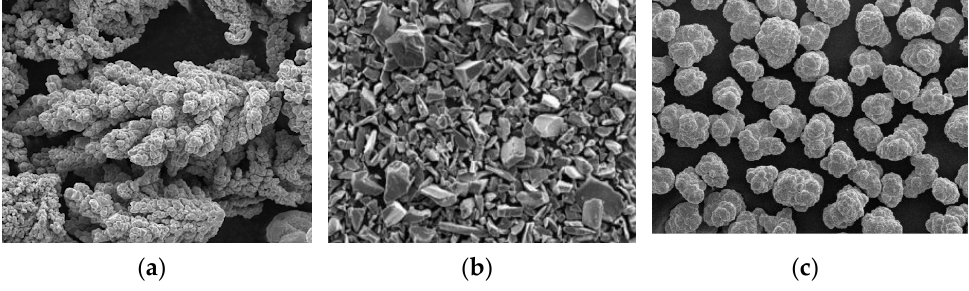
Figure 1. SEM images of ( a ) Cu powder, ( b ) TiC powder, and ( c ) Ni powder.